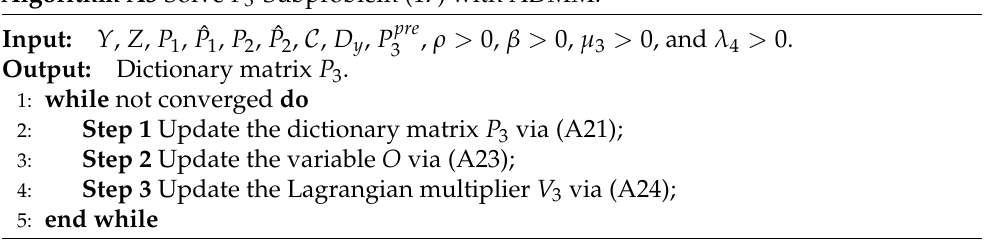
Algorithm A3 Solve P 3 -Subproblem (17) with